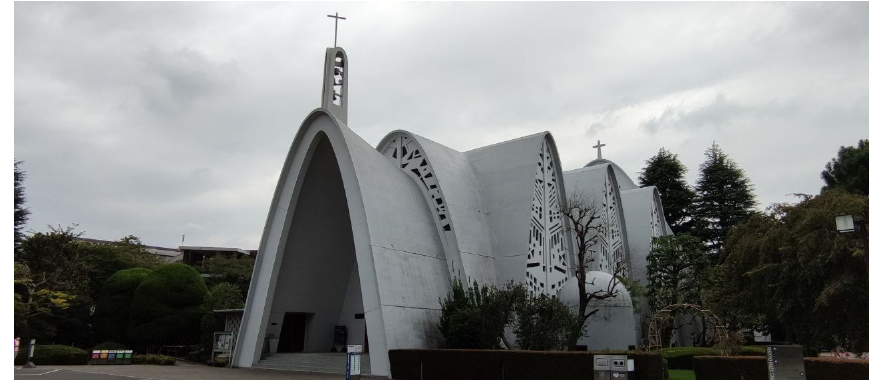
Figure 19. Parabolic forms in the Chapel of St. Paul at Rikkyo University, Japan.